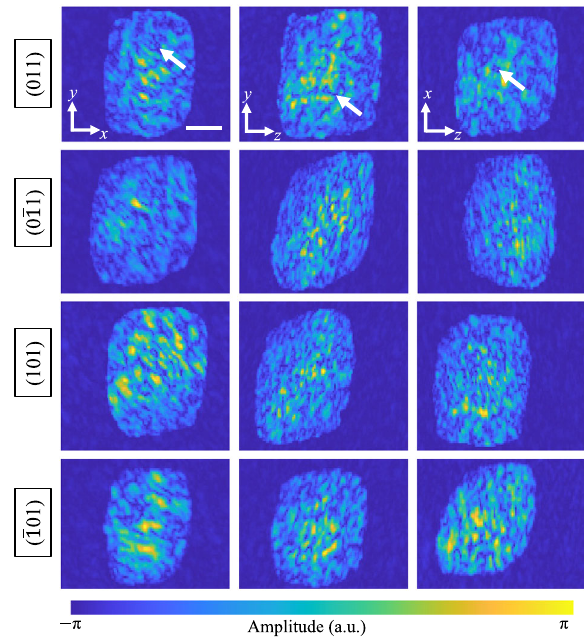
Fig. 4 Slices showing the electron density of irradiated chromium sample with the (011), (011), (101), and (101) Bragg ’ s re fl ections. Representative voids and dislocations are highlighted by white arrows featuring a low-amplitude core denoted as missing electron density. The scale bar is 1